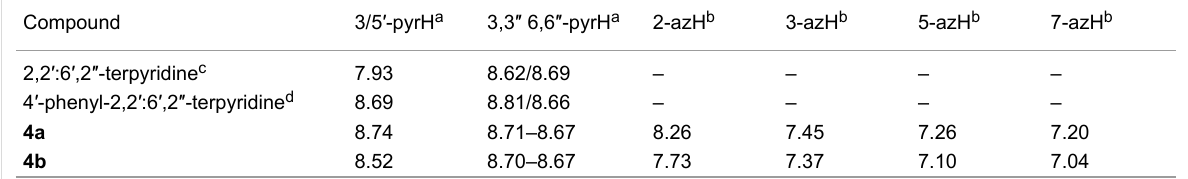
Table 2: Reaction conditions for the synthesis of 1-azulenyl-2 ′ -azachalcone 2a . Compound